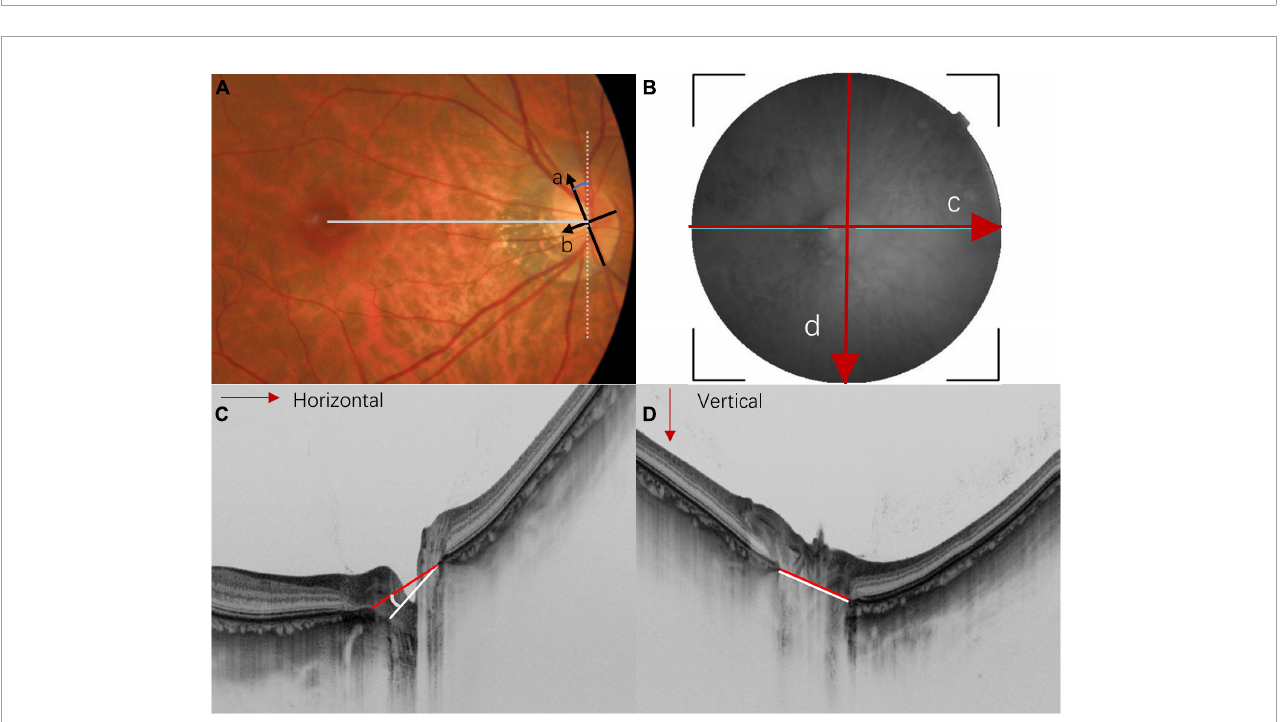
FIGURE3 Methods for measuring optic disc torsion, ovality index, and optical coherence tomography (OCT)-measured tilt angle. (A) In the fundus photography, the optic disc ovality index is determined by the ratio (a/b) of the longest diameter (arrow a) and the shortest diameter (arrow b). An ovality index larger than 1.3 is usually considered as optic disc tilt. The optic disc torsion angle is defined as the deviation of the longest axis (arrow a) from the vertical meridian (white dot line). The vertical meridian is defined as a vertical line perpendicular to a horizontal line that connects the center of the optic disc and the center of the fovea (straight gray line). (B) The en face SS-OCT image of the optic nerve head is measured by horizontal scan (red arrow c) and vertical scan (red arrow d). (C,D) Represent the horizontal and vertical cross-sectional scans of the optic disc, respectively. Myopic tilted discs are usually measured by the angle between Bruch’s membrane opening plane (also known as the reference plane) and the plane of the disc border. The red lines indicate the line connecting the Bruch’s membrane opening; the white lines indicate the line connecting the clinical boundary of the optic disc. The horizontal tilt angle (C) and vertical tilt angle (D) are measured between the red and white lines.